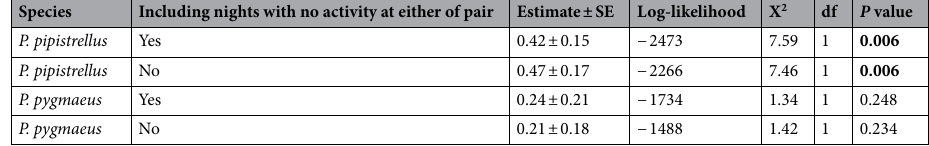
Species Including nights with no activity at either of pair Estimate ± SE Log-likelihood Χ 2 df P